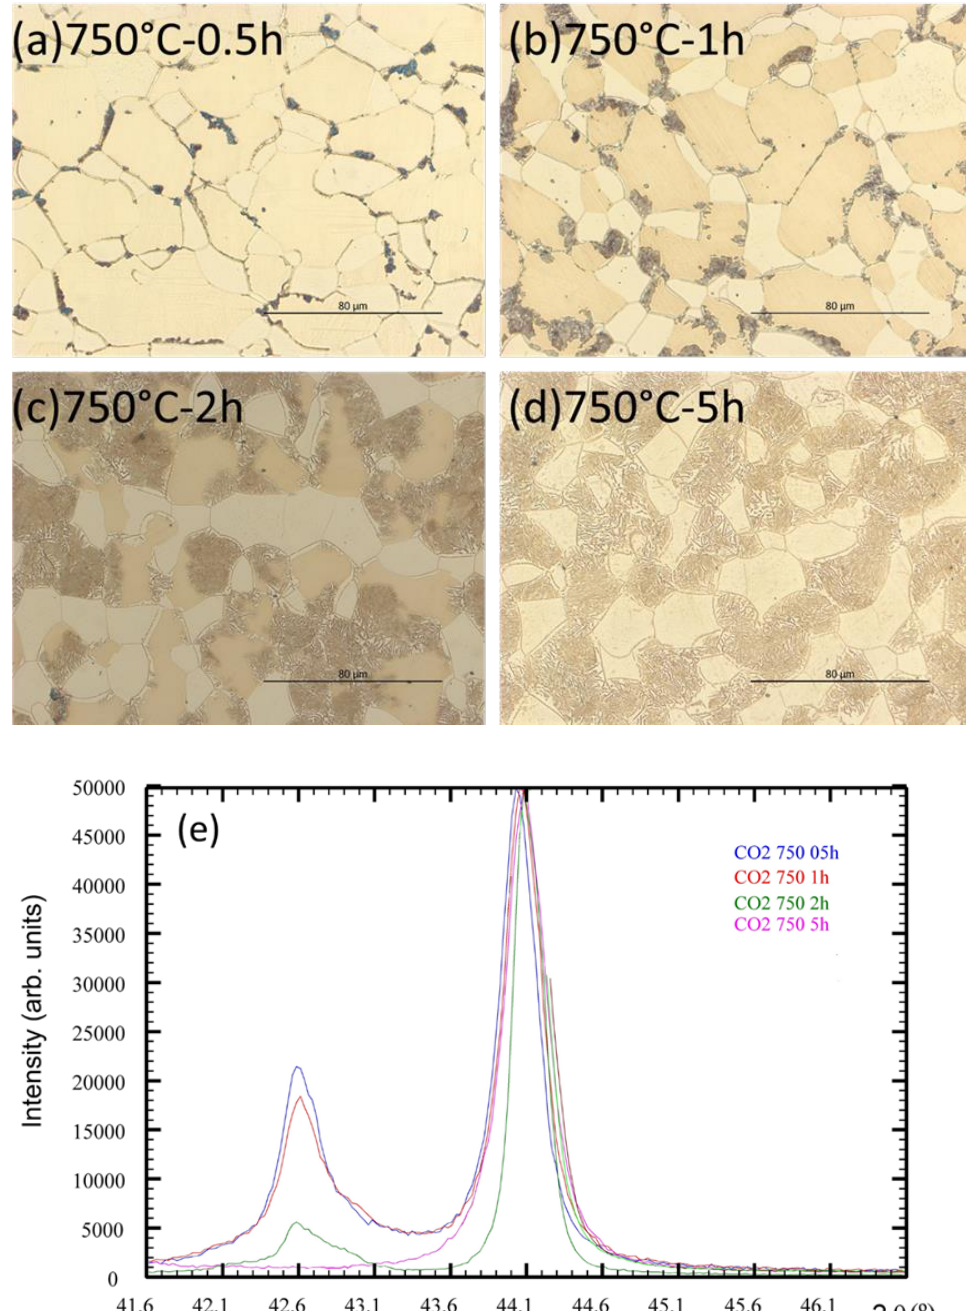
Figure 5. Optical microscope micrographs of the alloy after heat treatments performed at 750 °C for ( a ) 0.5 h, ( b ) 1 h, ( c ) 2 h and ( d ) 5 h. ( e ) Their corresponding diffractograms.